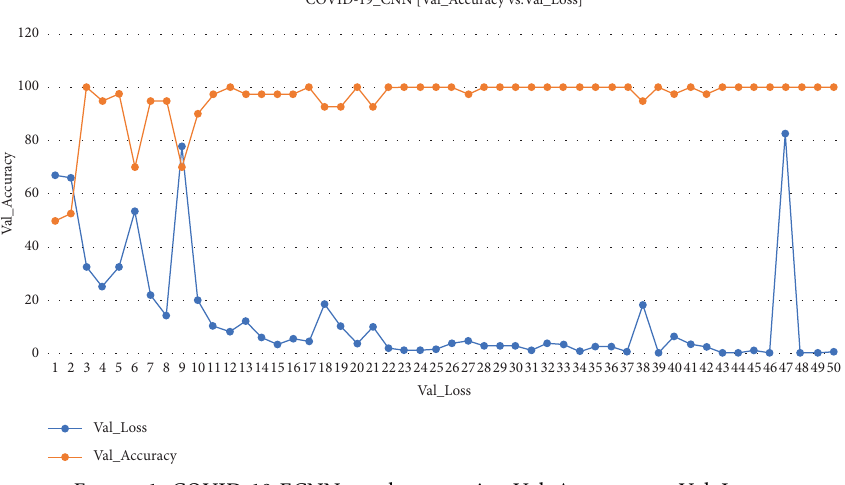
Figure 1: COVID-19 ECNN graph comparing Val_Accuracy vs. Val_Loss. Table 1: Comparison metrics with the existing system and ECNN technique. Sl.